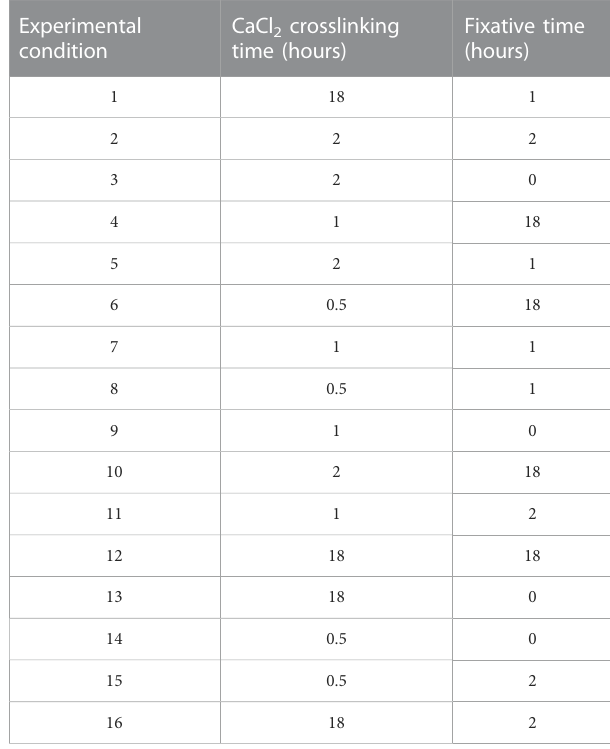
TABLE 2 Design of experiments (DOE) with two factorial design and four levels of each factor for a full factorial design. Factors were CaCl 2 crosslinking time (hours) and fi xation time (hours). 50mM CaCl 2 crosslinking was performed for 0.5, 1, 2 h and overnight (18 h) while fi xation time was 0, 1, 2 h and overnight (18 h). Each set of experiments was done in parallel for each fi